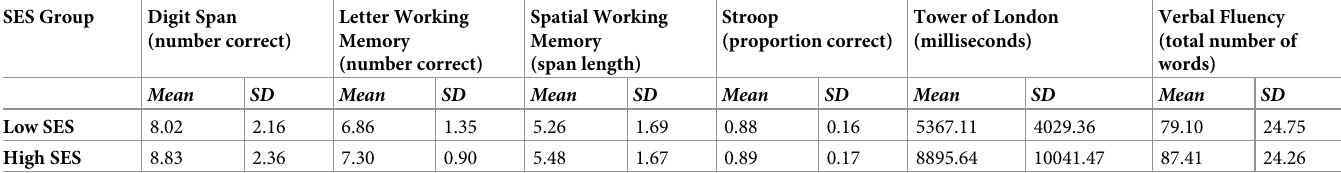
Table 2. Descriptive statistics for each EF measure by SES group ( N = 185).